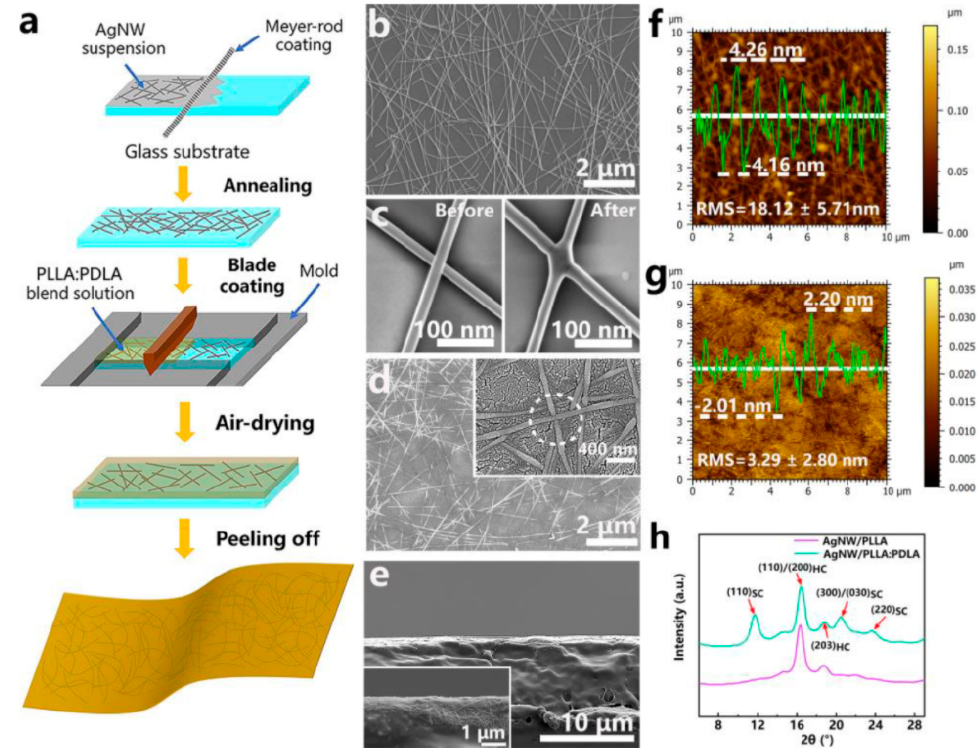
Figure 15. ( a ) Fabrication steps of aAgNWs/PLA film. SEM images of ( b ) the blended film + AgNWs.